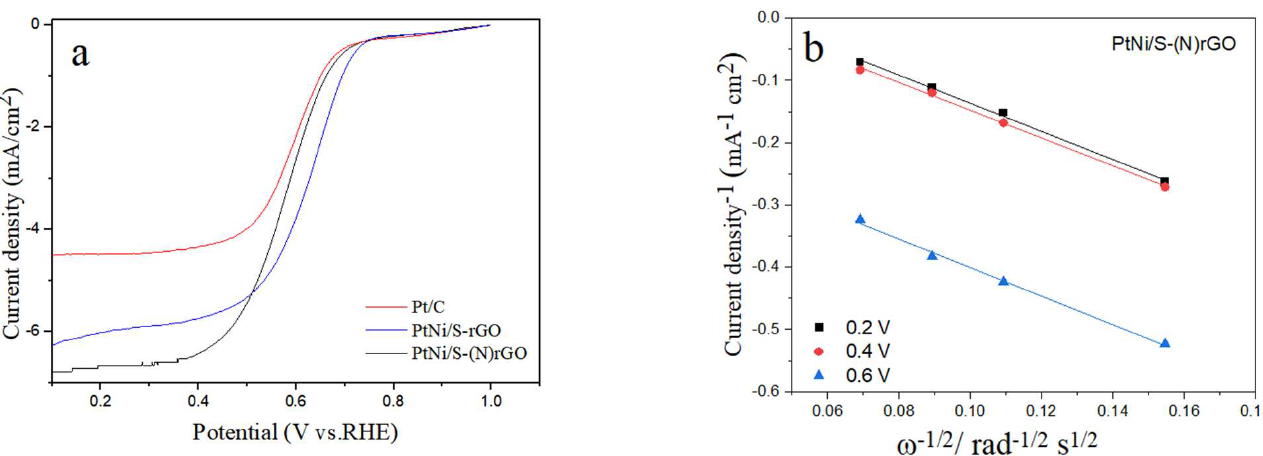
Figure 6. In the Pt/C, PtNiCo/S−rGO, and PtNiCo/S−(N)rGO catalysts ( a ) CV curves for redox reaction ( b )Limited current for ORR.